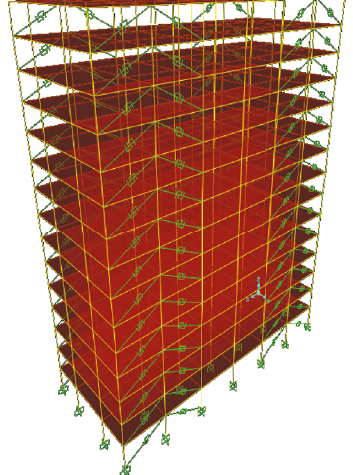
Figure 19: Finite element analysis